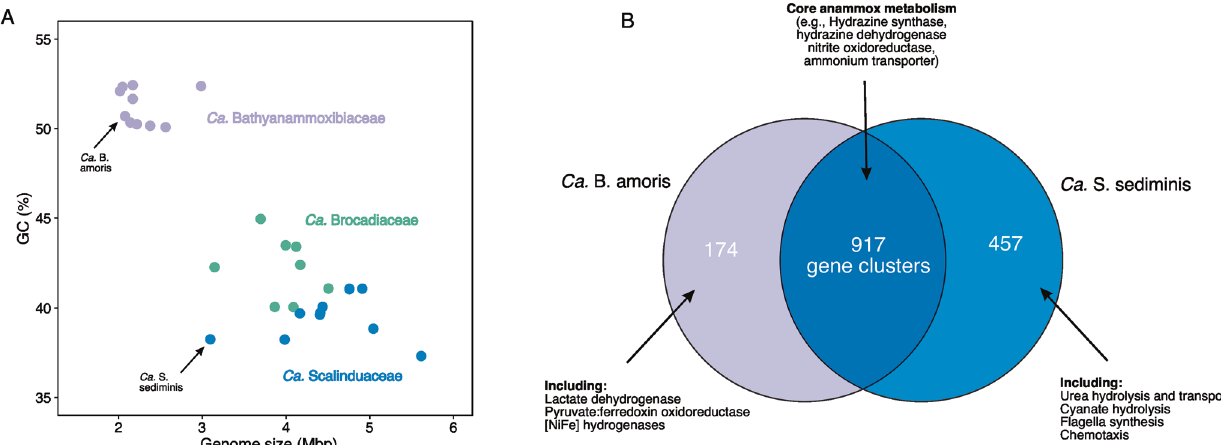
Fig. 5 Comparative analysis of genomes of the dominant anammox bacteria in marine sediments. A A plot of genome size against GC content of the three families of anammox bacteria genomes. Ca . Bathyanammoxibius amoris (in this study) and Ca . Scalindua sediminis (Ref. [13]), representatives of the families Ca . Bathyanammoxibiaceae and Ca . Scalinduaceae widespread in marine sediments, are highlighted. B Venn diagram showing the shared and unique gene clusters between Ca . B. amoris and Ca . S.